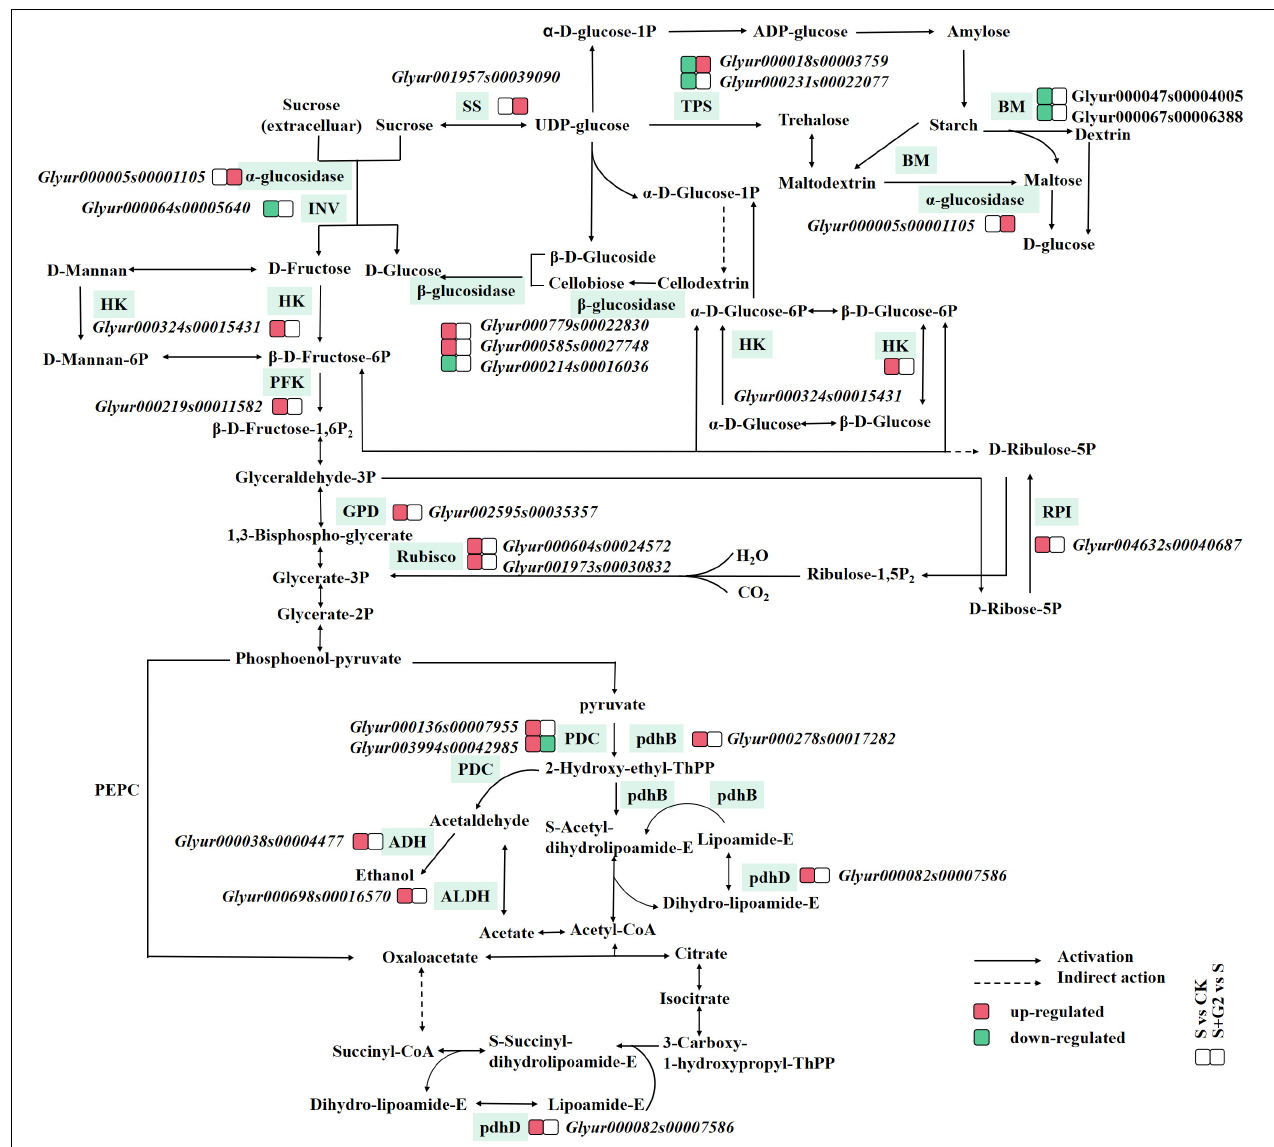
FIGURE 4 | A figure of the mechanism by which B. cereus G2 improves the salt tolerance of G. uralensis by regulating DEGs related to carbohydrate metabolism. CK, control group; S, salt stress group; S + G2, salt stress combined with the G2 group; GPD, glyceraldehyde-3-phosphate dehydrogenase (NADP+); Rubisco, ribulose-bisphosphate carboxylase small chain; RPI, ribose 5-phosphate isomerase A; INV, beta-fructofuranosidase; TPS, trehalose 6-phosphate synthase/phosphatase; BM, beta-amylase; SS, sucrose synthase; HK, hexokinase; PFK, 6-phosphofructokinase 1; pdhB, pyruvate dehydrogenase E1 component beta subunit; PDC, pyruvate decarboxylase; ADH, S-(hydroxymethyl)glutathione dehydrogenase/alcohol dehydrogenase; pdhD, dihydrolipoamide dehydrogenase; ALDH, aldehyde